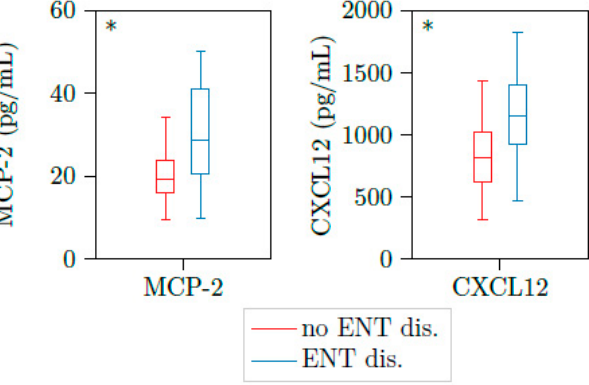
Figure 1. MCP2 and CXCL12 are upregulated in patients with active AAV and ENT involvement. Illustration of MCP2 and CXCL12 plasma concentrations of 23 samples with active PR3-AAV. Both cytokines were significantly elevated in patients with ear, nose and throat involvement ( n = 11) versus those without these organ’s involvement ( n = 10). * p < 0.05, boxes and whisker plots present distribution of the median, the upper, and lower quartile, the whiskers with 1.5 of the interquartile distances, as well as the outliers.